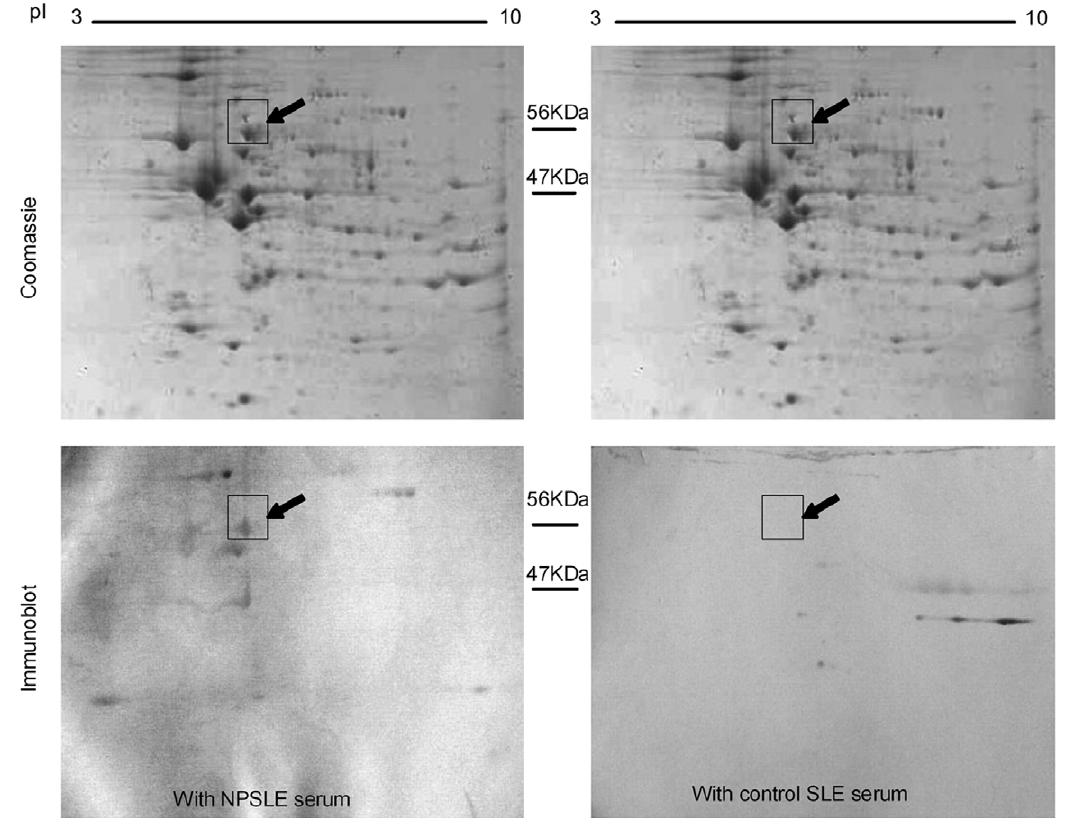
Figure 1. Identification of a -internexin (INA) as target antigen in NPSLE serum. The proteins extract from rat brain and spinal cord were separated by 2-DE and stained with colloidal Coomassie blue (upper panels), or immunoblotted with NPSLE (lower left panel) or control (lower right panel) sera. An immunoreactive spot at , 56 kDa/ pI 5.2 was excised and subjected to MALDI-TOF MS. By searching the protein database SwissProt, the peptide mass-mapping matched rat a -internexin (INA, alpha; a -INA; Rattus norvegicus, gi|9506811, kDa 56081.6, PI 5.2, protein score 99.99%). The data is representative of 4 independent experiments.